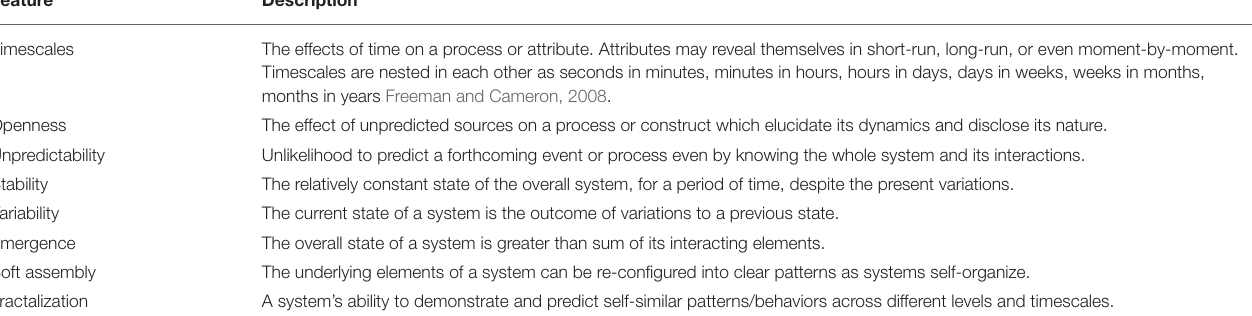
TABLE 1 | Additional features of